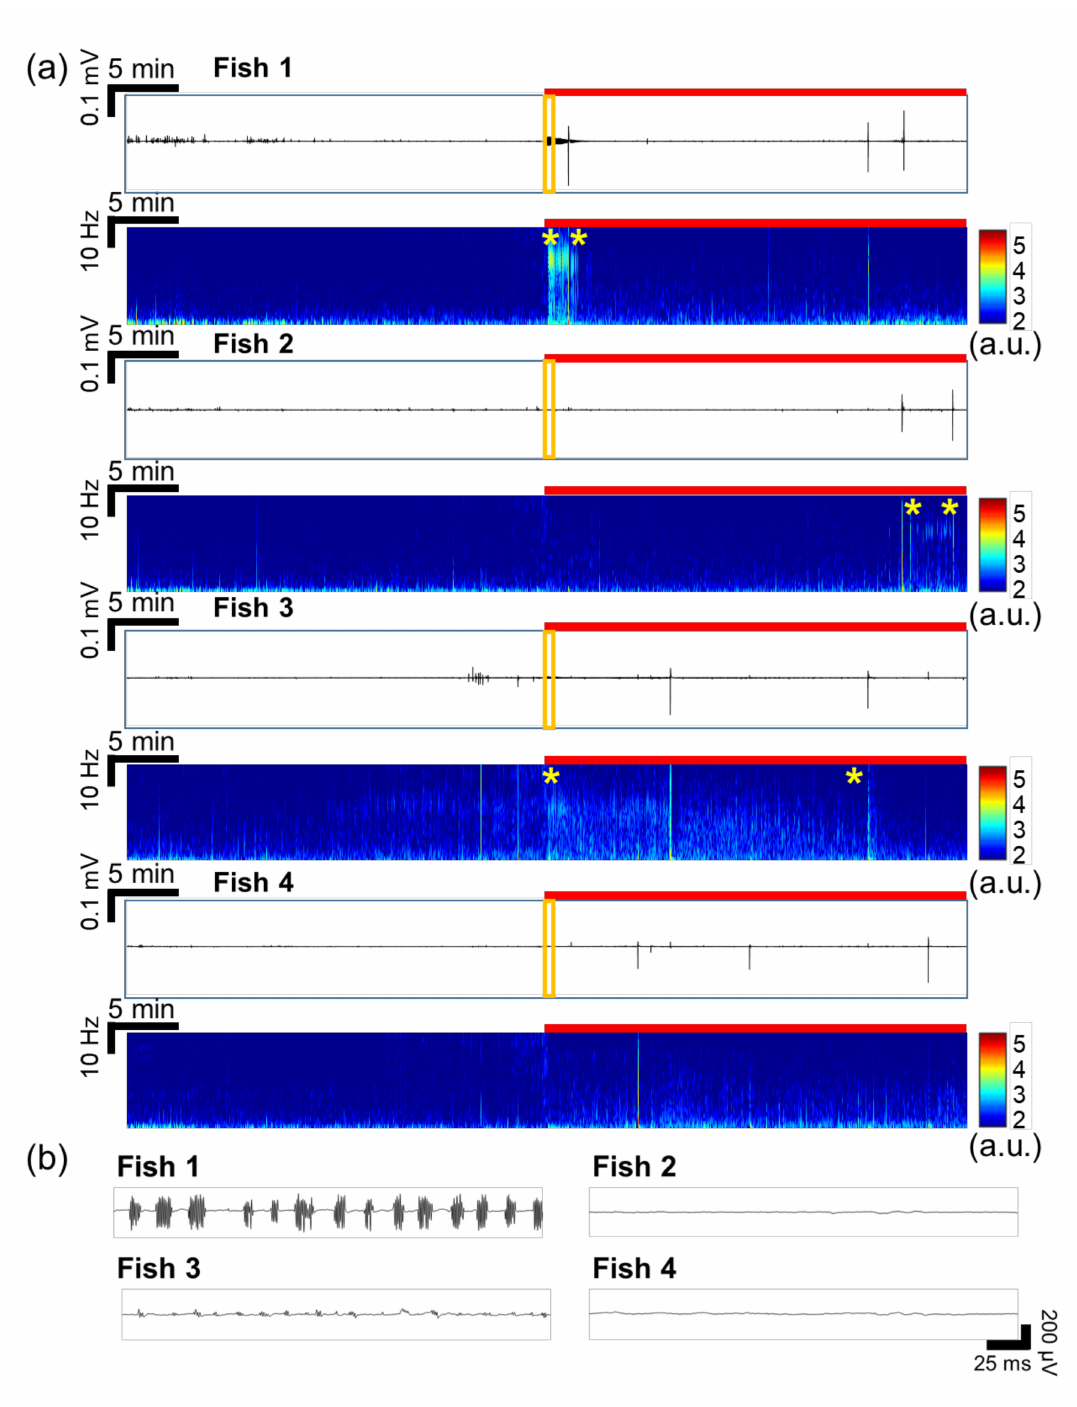
Figure 4. EEG signals recorded simultaneously from 4 larval zebrafish in the VPA-treated group. ( a ) Recorded raw data in time domain and their time-frequency plots (0.5–35 Hz). The red bar represents the duration of PTZ application. The intervals marked by two yellow stars show inter-ictal events. ( b ) Magnified views of the signals marked by the orange boxes in ( a ). In fish 1 and 3, inter-itcal signals were observed as soon as PTZ was applied, regardless of VPA treatment. In all fish, ictal events